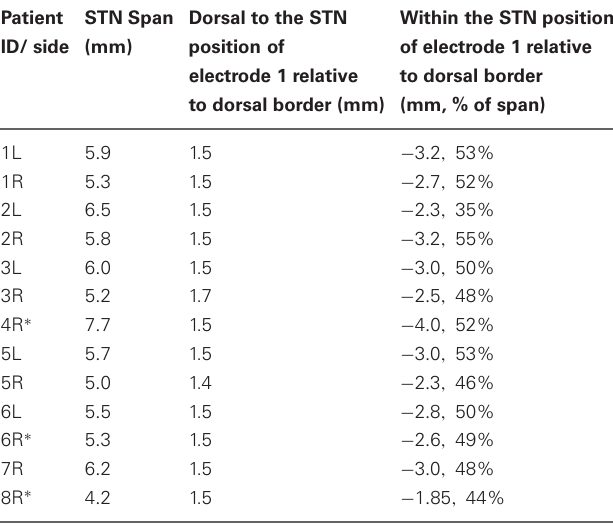
Table 1 | Locations of DBS During LFP Recording for each case. Patient STN Span Dorsal to the